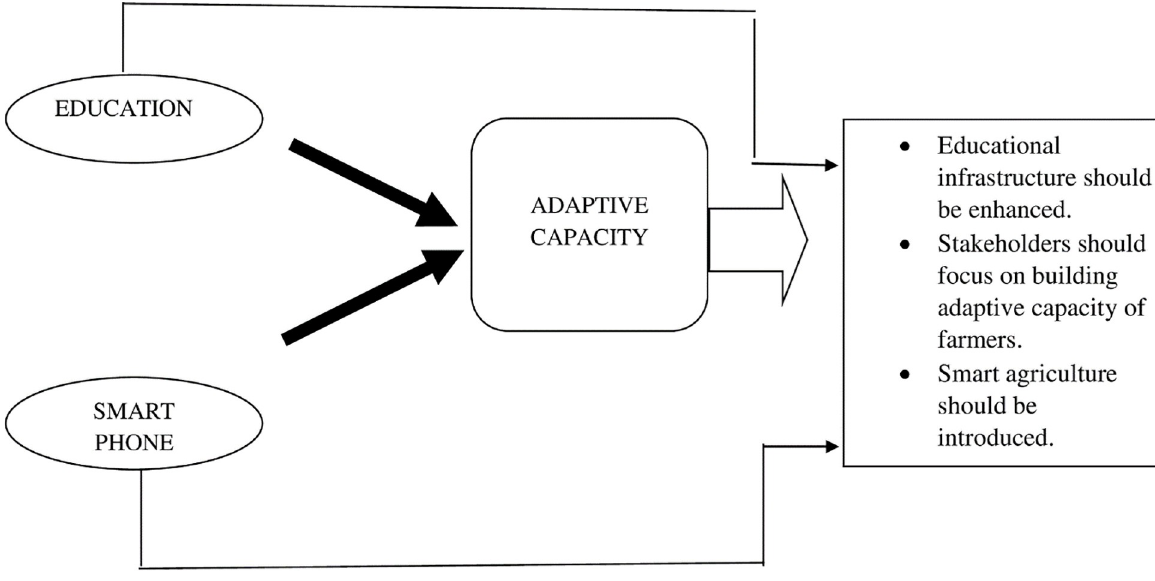
Fig 3. Policy implication